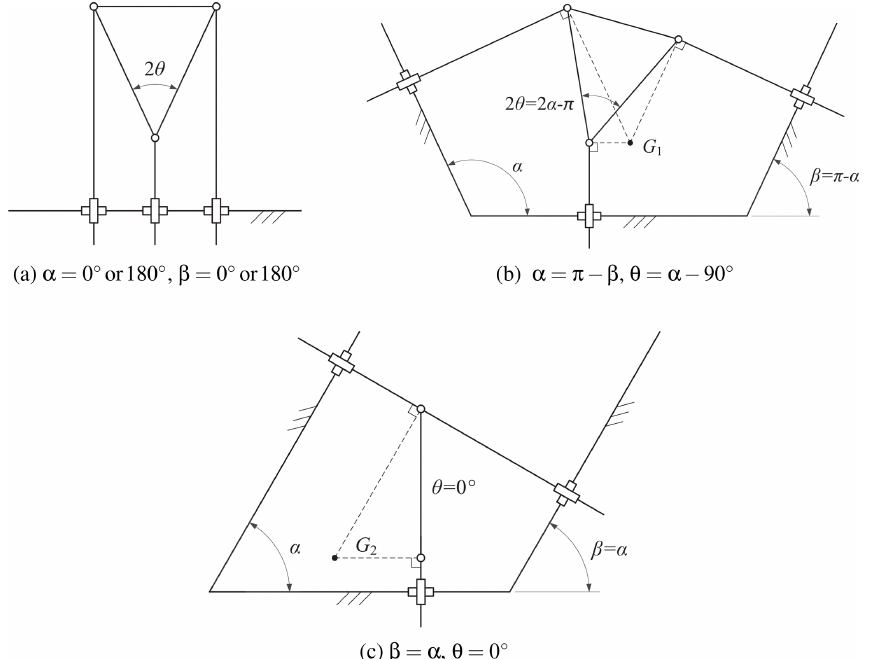
Figure 3. Singular shapes of the 3-PKM. The shape of the base platform in (a) can be viewed as a straight line, while the base platforms in (b) and (c) are isosceles trapezoid and parallelogram, respectively, if we virtually close the opening by drawing a line parallel to the bottom